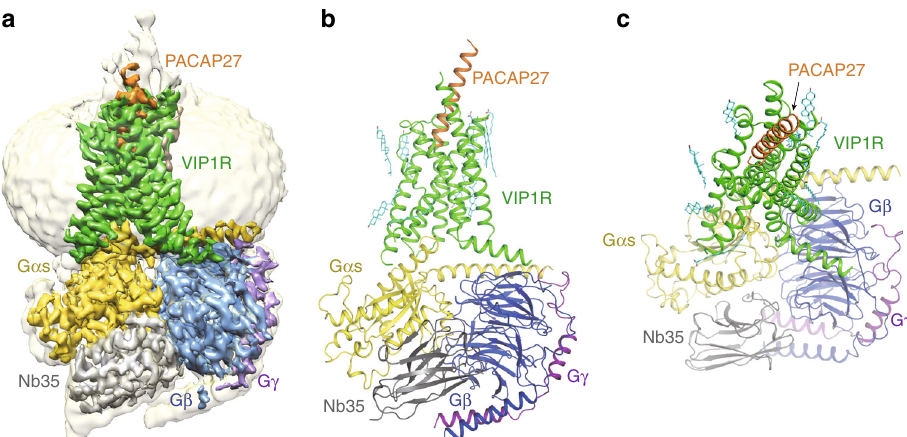
Fig. 2 The overall cryo-EM structure of PACAP27 – VIP1R – Gs complex. a A cut-through view of the cryo-EM map of PACAP27 – VIP1R – Gs complex with a disc-shaped micelle. b A cartoon representation of the PACAP27 – VIP1R – Gs complex. c Extracellular view of the PACAP27 – VIP1R – Gs complex structure. PACAP27 is colored in orange; VIP1R in green; G α s Ras-like domain in yellow; G β subunit in blue; G γ subunit in purple; Nb35 in gray; and lipid molecules in